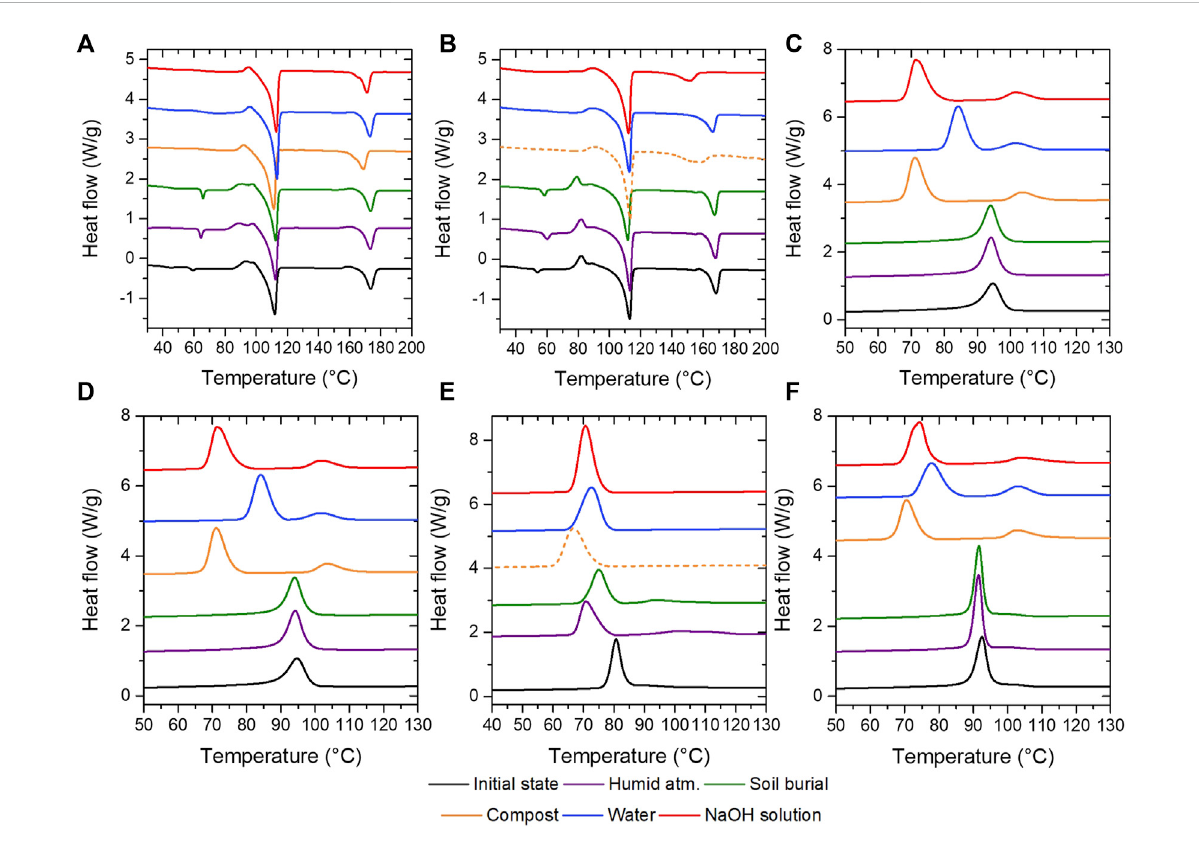
FIGURE 12 Melting curves ( fi rst heating ramp) of (A) PBS/PLA, (B) PBS/PLA/P-Cl, and (C) PBS/PLA/A-M blends, and crystallization curves of (D) PBS/PLA, (E) PBS/PLA/P-Cl, and (F) PBS/PLA/A-M